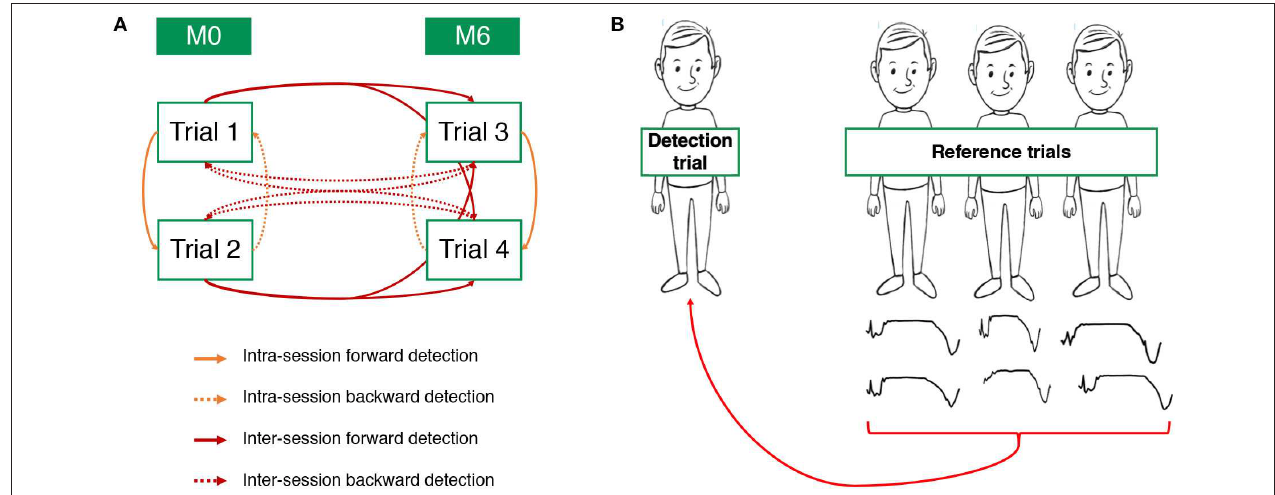
FIGURE 1 | Definition of the different pairs of reference/detection trials analyzed by the intra-individual template-based detection (IITD) algorithm (A) and the intra-group template-based detection (IGTD) algorithm (B)